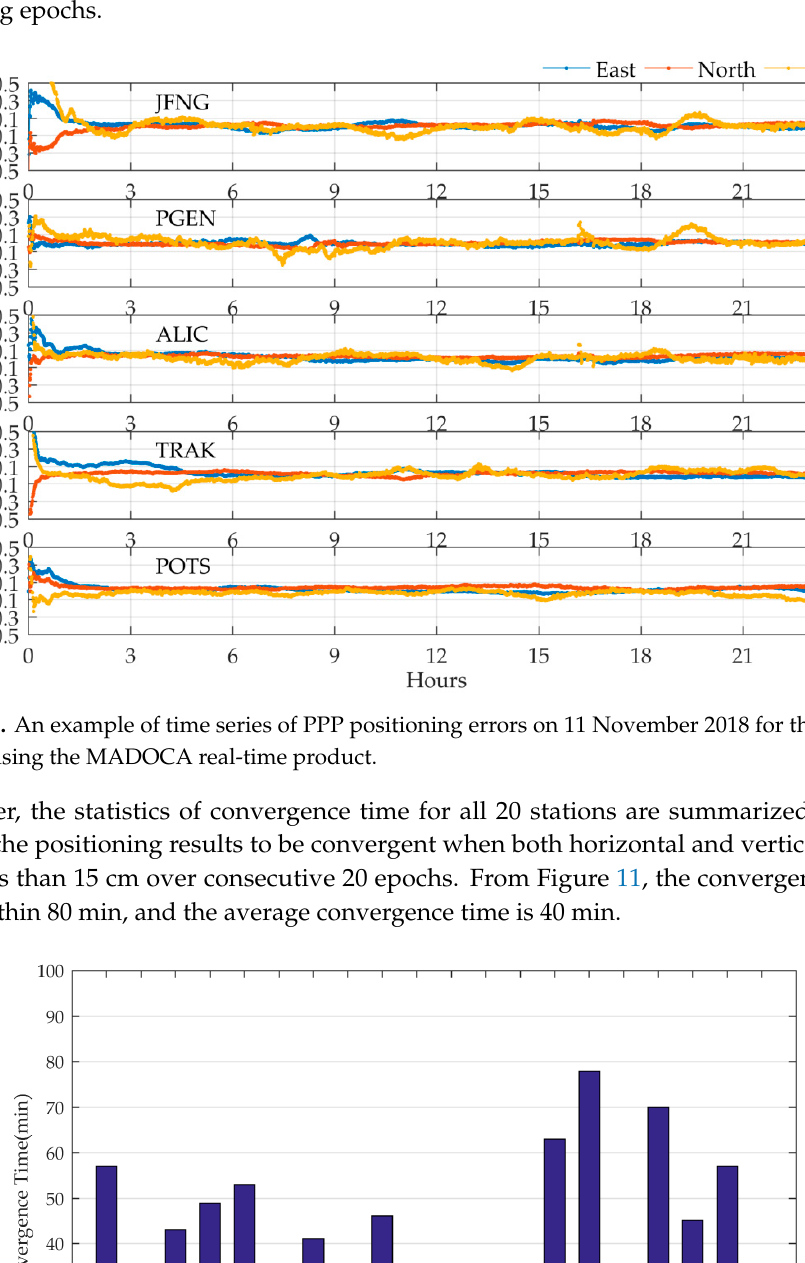
Figure 9. The distribution of 20 IGS stations for PPP validation.